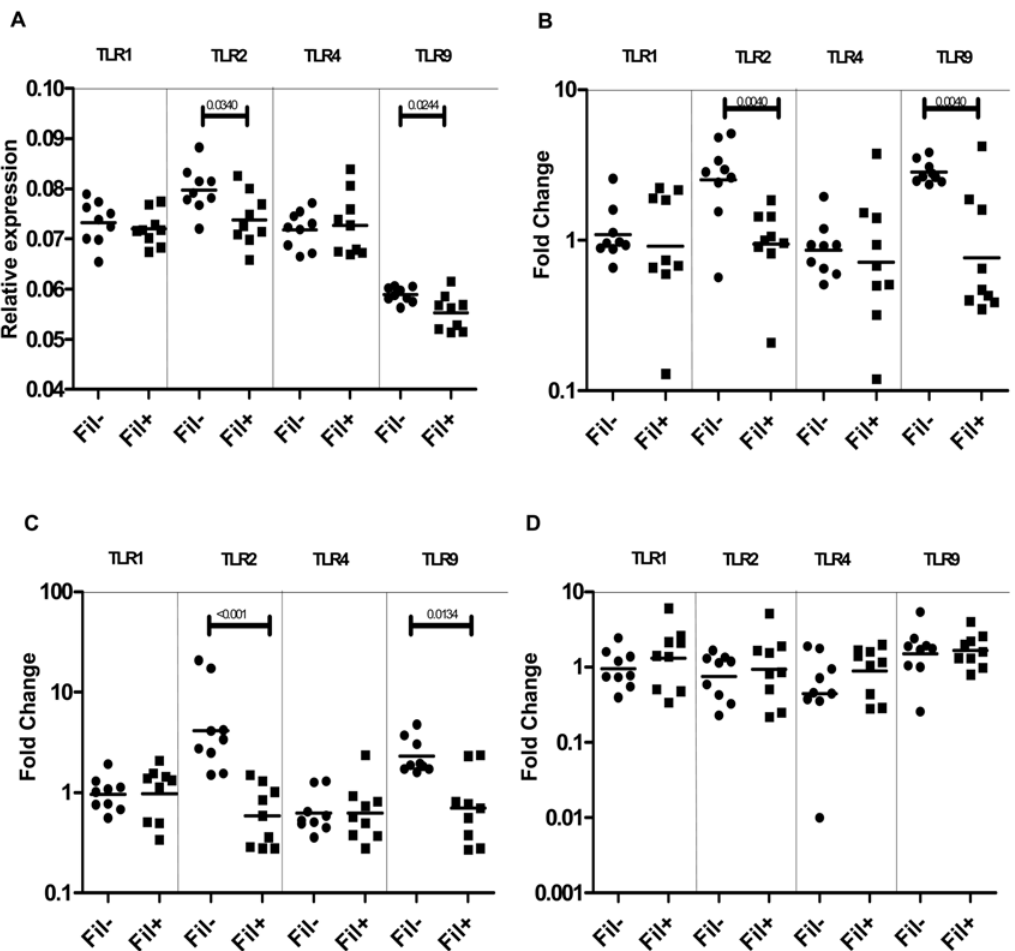
Figure 1. Filarial infection is associated with decreased expression of TLR2 and TLR9 at baseline and following PPD and CFP stimulation in latent TB patients. PBMC from PPD + Fil 2 ( n =9) and PPD + Fil + ( n =9) patients were examined at baseline (A) or stimulated with PPD (B) or Mtb CFP (C) or TT (D) for 24 hours, and TLR1, 2, 4, and 9 mRNA levels were measured by real-time RT-PCR. Results are shown as relative expression at baseline (A) or fold change over media control (B, C, and D). p values were calculated using the Mann-Whitney